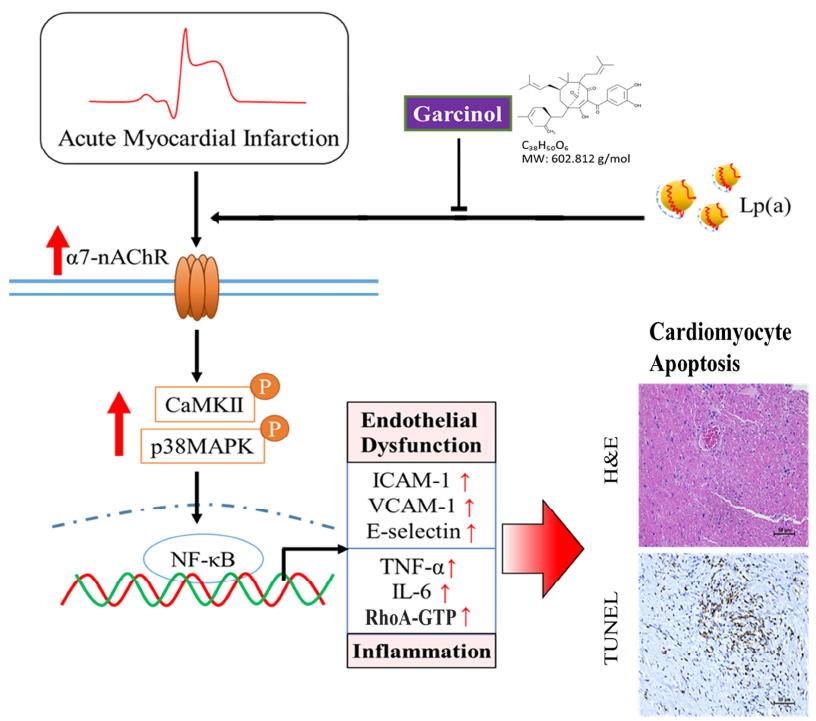
Figure 7. Garcinol significantly decreased the Lp(a)/ α 7-nAChR-mediated protein expression levels of inflammatory cytokines and phosphorylation activation of CamKII/p38 MAPK signaling, resulting in reduced post-infarct cardiomy- ocyte apoptosis.